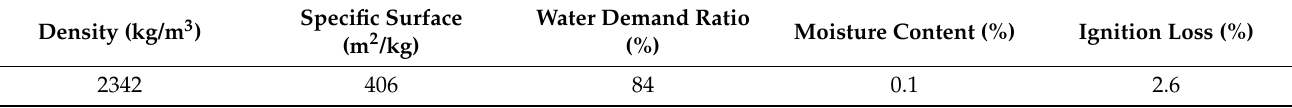
Table 3. Physical properties of fly-ash.